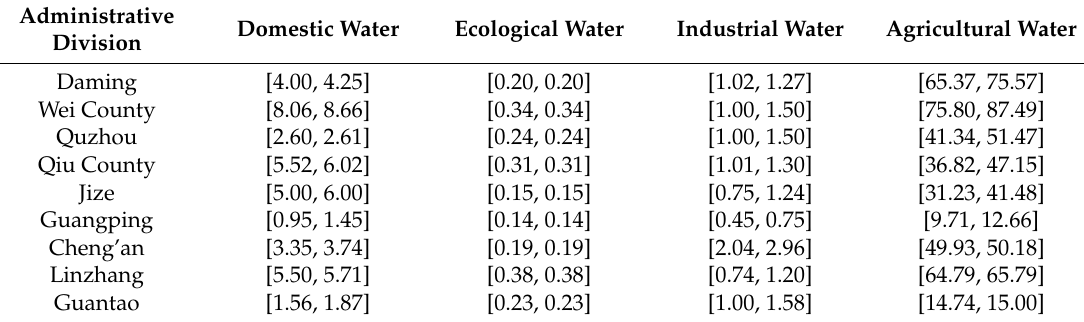
Table 5. Result of groundwater allocated to every user (10 6 m 3